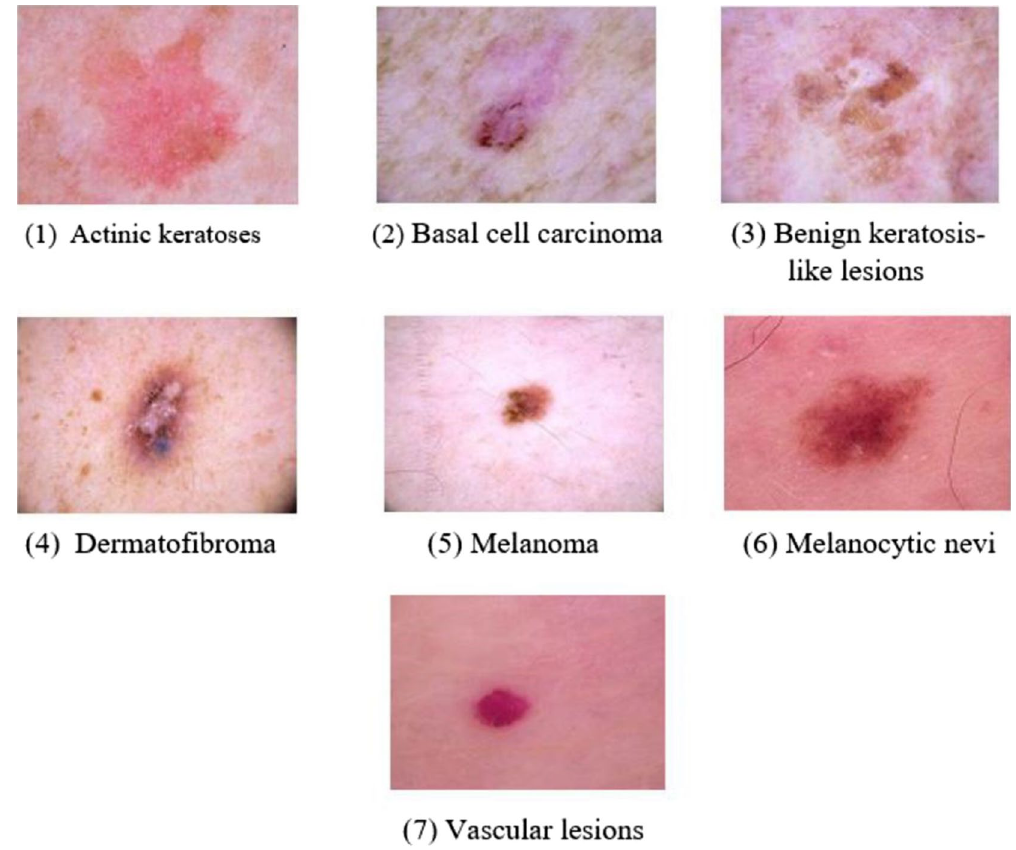
Figure 1. Sample images for the seven skin lesion categories from HAM10000